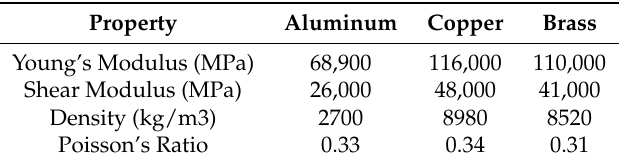
Figure 5. ( a ) Half section view of the 3D FE model. ( b ) Mesh density of workpiece. Table 3. Mechanical properties of Al, Cu, Br